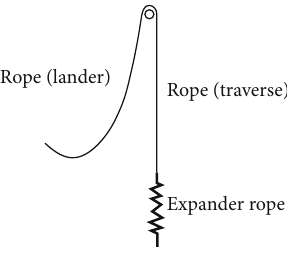
Figure 8: NEST con fi guration for each of the ropes. The main part of the rope is a very sti ff rope. At the bottom part, an expander rope (less sti ff rope) with length of 1.50m is added, therefore pictured as a spring. At the top part of the traverse pole, the turning wheel can be seen. For a better handling in the solving procedure, the rope can be split into a lander and a traverse part.